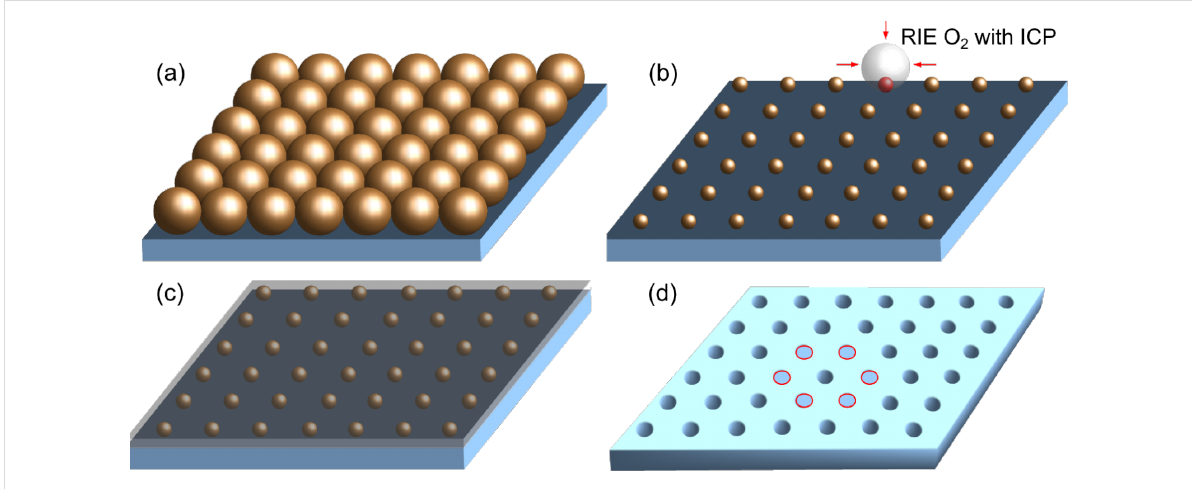
Figure 2: Illustration of the four steps in down-scaling of the particles of a polystyrene monolayer to the 10-nm range, which is to later serve as a nano-array mask. (a) Forming a self-assembled hexagonal-close-packed monolayer. (b) Reactive oxygen plasma with ICP is used to reduce the size of the particles. (c) A reinforcing layer of aluminum is deposited to serve as a hard mask. (d) A lift-off of the particles by etching completes the fabrica- tion of the